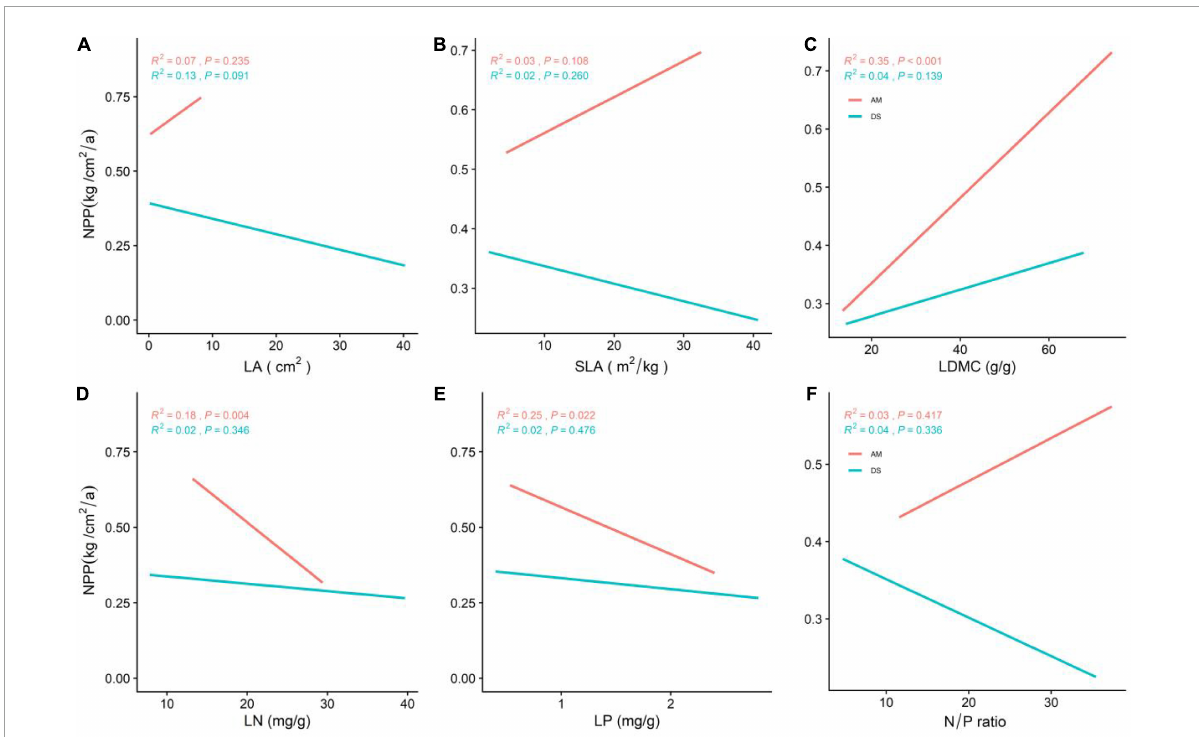
FIGURE2 General linear correlations between community leaf traits and the NPP of AM and DS. (A) General linear relationship between LA and the NPP of AM and DS; (B) general linear relationship between SLA and the NPP of AM and DS; (C) general linear relationship between LDMC and the NPP of AM and DS; (D) general linear relationship between LN and the NPP of AM and DS; (E) general linear relationship between LP and the NPP of AM and DS; (F) general linear relationship between N/P and the NPP of AM and DS. LA represents leaf area; SLA represents specific leaf area; LDMC represents leaf dry matter content; LN represents leaf nitrogen content; LP represents leaf phosphorus content; N/P represents leaf nitrogen and phosphorus ratio. The red line represents the NPP of AM and the green line represents the NPP of DS; R 2 represents the fit of the model, and P represents the